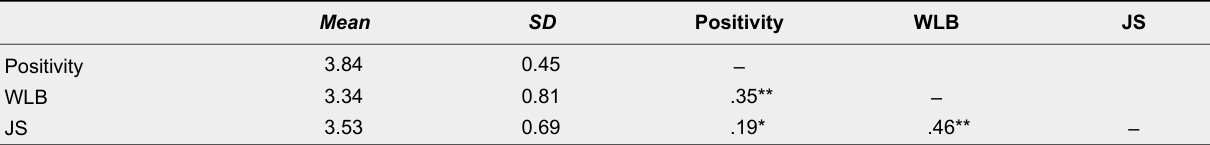
Means, Standard Deviations, and Correlations Between Study Variables (N =